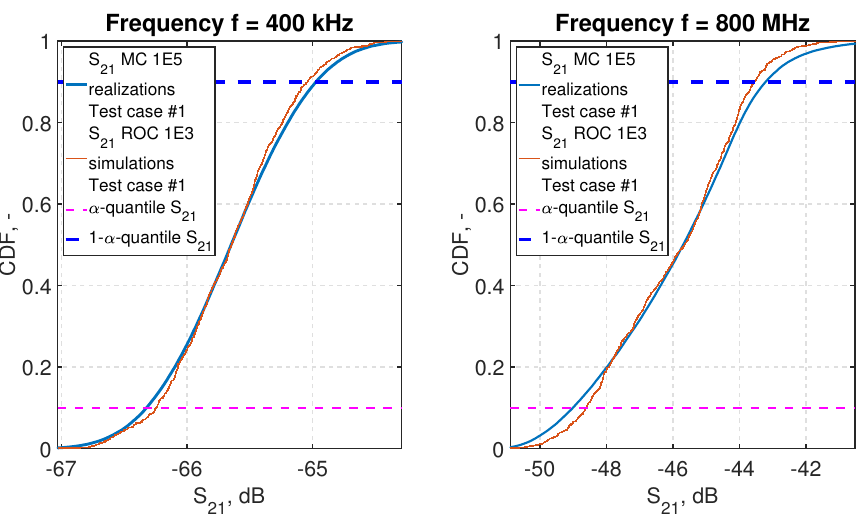
Figure 10. Illustration of ROC CDF reconstruction (orange dashed curve) compared to MC reference data (blue plain curve) through filter performance ( S 21 ) for Test case #1/Channel #1: At low frequency level f L = 400 kHz (left side) and at high frequency level f H = 800 MHz (right side). α = 10% quantile and 1 − α = 90% levels are given as an illustration, respectively, through pink and blue dotted